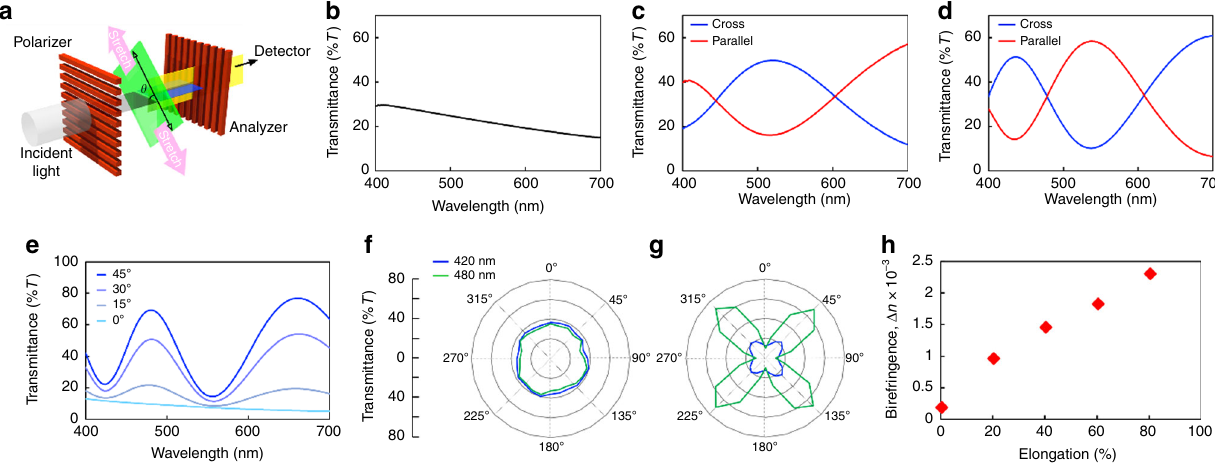
Fig. 3 Polarized ultraviolet-visible (UV-vis) spectroscopy of CNC-E. a Schematic illustration of the experimental setup for measuring the transmission polarized UV-vis spectrum. b Transmitting polarized UV-vis spectra of static CNC-E between crossed polarizers. c Polarized transmission UV-vis spectra of 40%, d 80% elongated CNC-E under crossed and parallel arrangements of polarizers. e Polarized light intensities of stretched CNC-E. The sample was kept stretched and the stretching direction was oriented 0, 15, 30, and 45° to the polarization axis of the polarizer. f Polar plots of polarized light intensities of static and g stretched CNC-E relative to the polarizer. h Birefringence estimation of stretched CNC-E. Birefringence increases as the sample is stretched. (Stretching direction of samples are oriented 45° relative to the polarizer unless otherwise noted.)